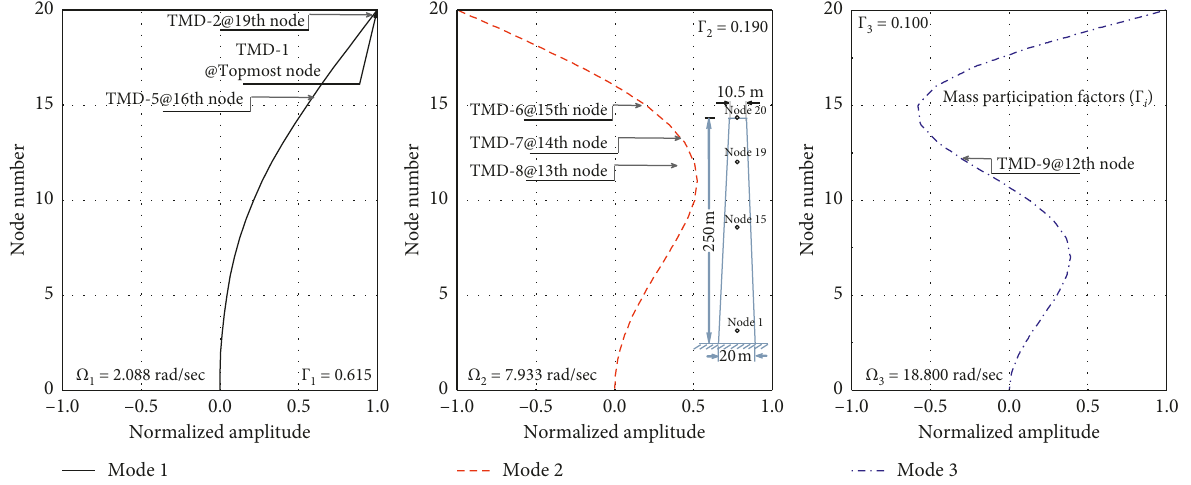
Figure 2: Mode shapes and frequencies of the uncontrolled